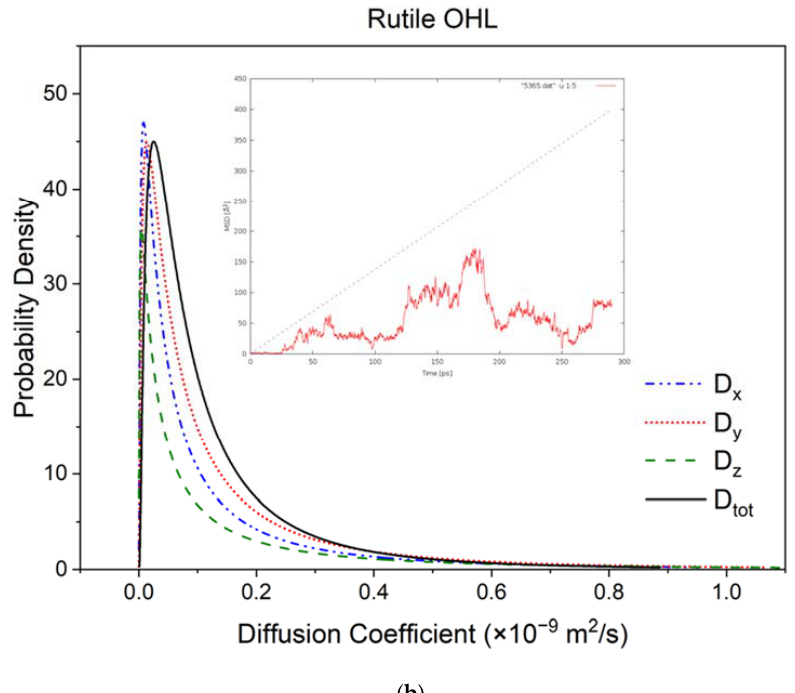
Figure 3. Probability distribution of self-diffusion coefficients of each individual water molecule averaged over 300 ps sub-intervals for rutile (110) ( a ) IHL ( b ) OHL. Diffusivities of the x , y , z directions are shown in blue, red and green dashed lines, respectively. The total diffusivity of individual molecules is represented by the solid black line. Note that these molecules are distinct from the average with 95% confidence. The MSD plotted in the graph refers to one individual water molecule present in both IHL and OHL, respectively. The self-diffusivity experimental value for bulk-water (2.3 × 10 − 9 m 2 s − 1 ) is represented by the grey dotted line.